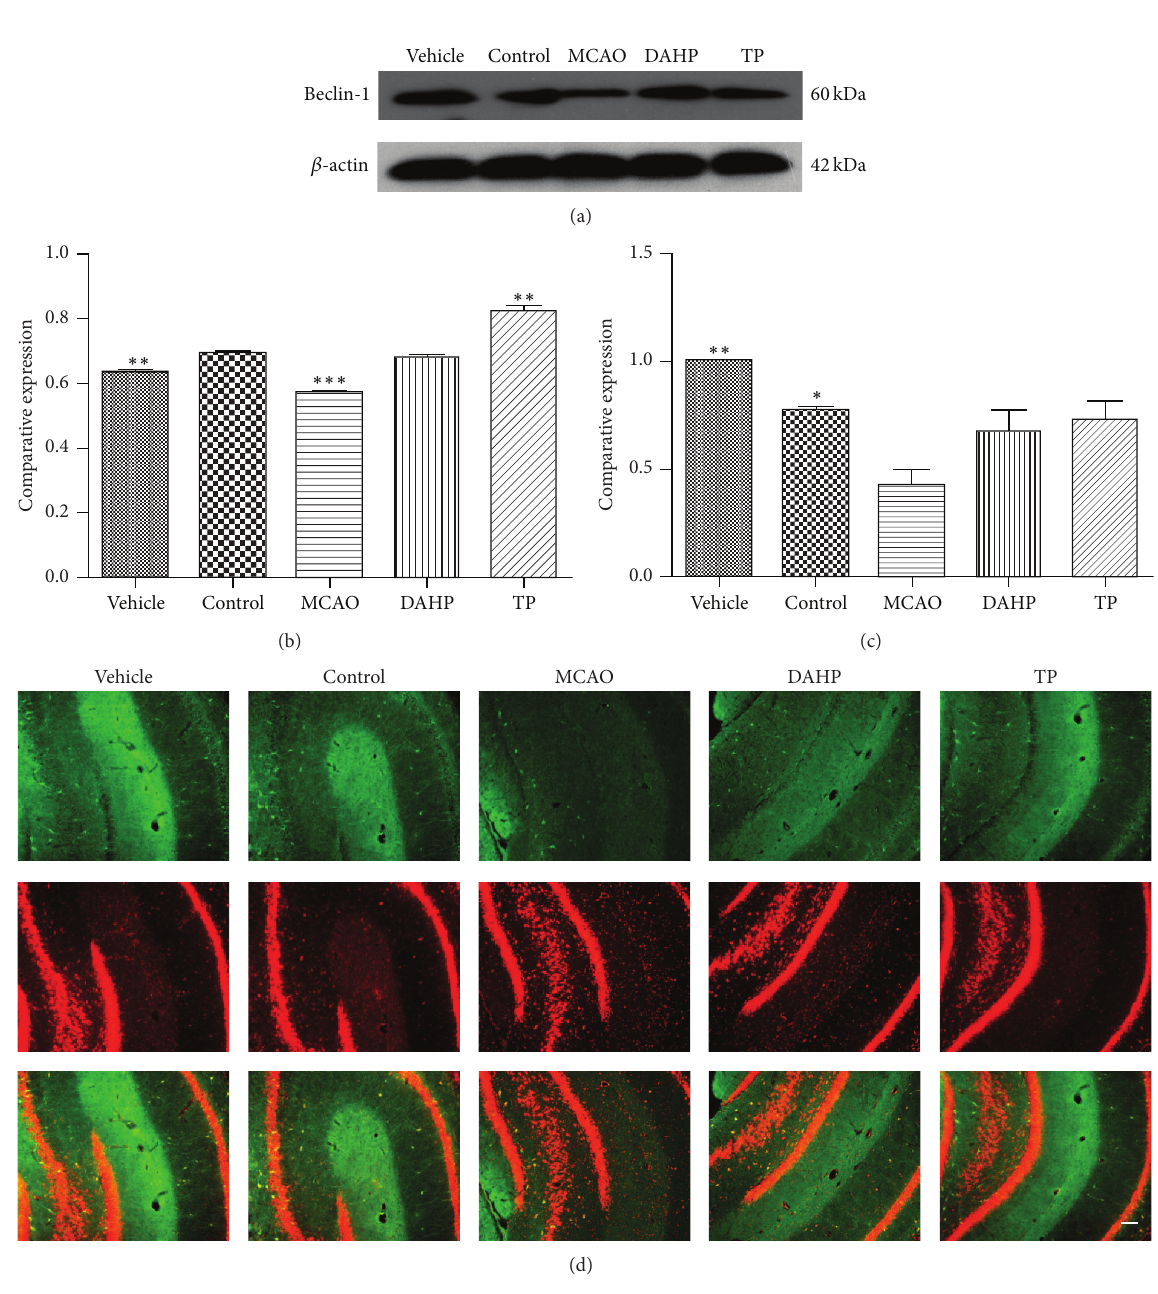
Figure 3: The expression level of Beclin-1 was detected by immunochemistry and western blot. Both immunochemistry and western blot staining present an increasing tendency in Beclin-1 expression in DAHP and TP and a decrease in MCAO. (a) There is no obvious difference between vehicle and control. The image shows a decrease in MCAO, while DAHP and TP were more or less back to the same level as vehicle and control. (b) There has been significance among mean changes in Beclin-1, as compared with vehicle and normal control; MCAO has the trend to descend. (c) The mean change in Beclin-1 expression detected by immunochemistry has significance, also owning comparison among MCAO, DAHP, and TP. (d) The immunochemistry staining shows similar changes in Beclin-1 expression in each group as in (a). Bar = 100 𝜇